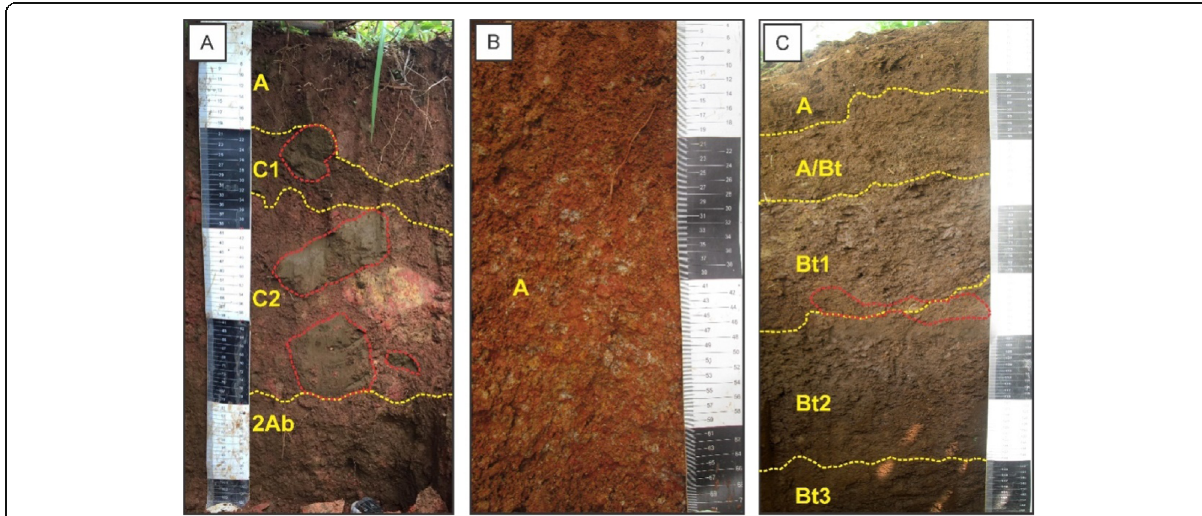
Fig. 9 Soil morphology on the bodies parts of landslide: Tegalsari ( a ), Wonogiri ( b ), and Manglong ( c ). Note: Red lines show boundaries of broken horizon. Soil profile in Wonogiri shows pedoturbated horizon